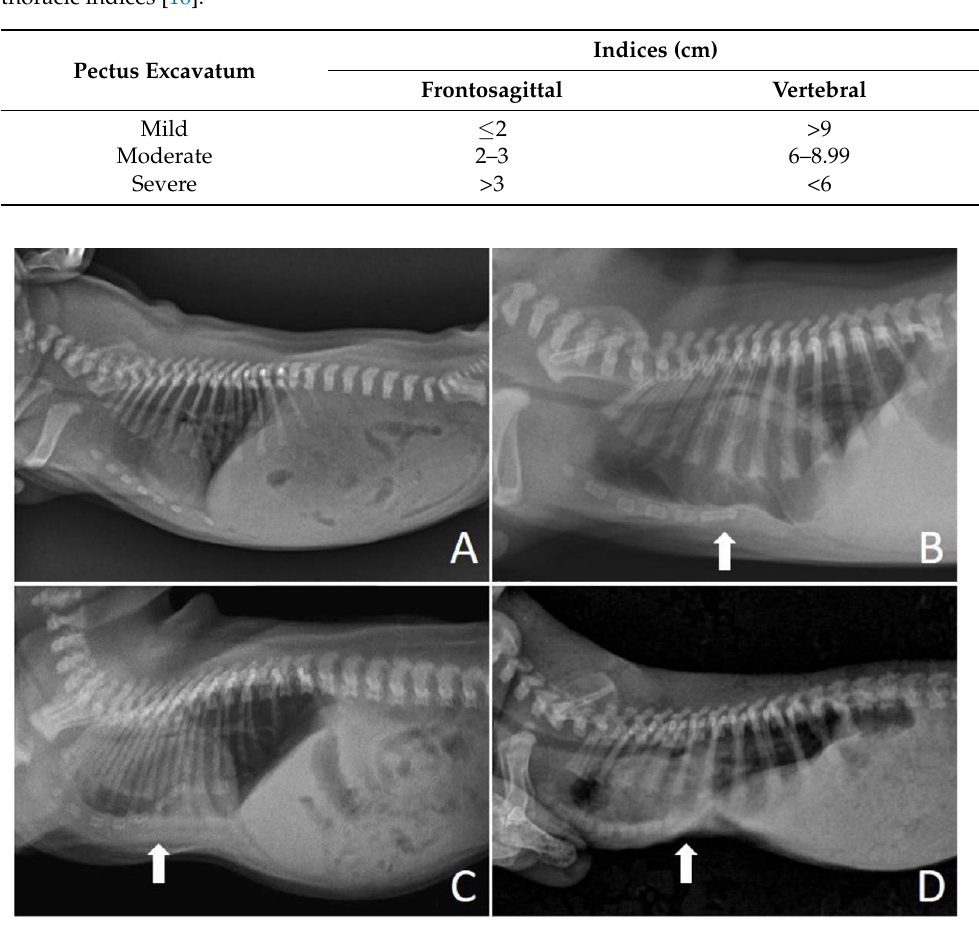
Figure 2. Chest X-rays of neonatal puppies of brachycephalic breeds. ( A ) Chest without